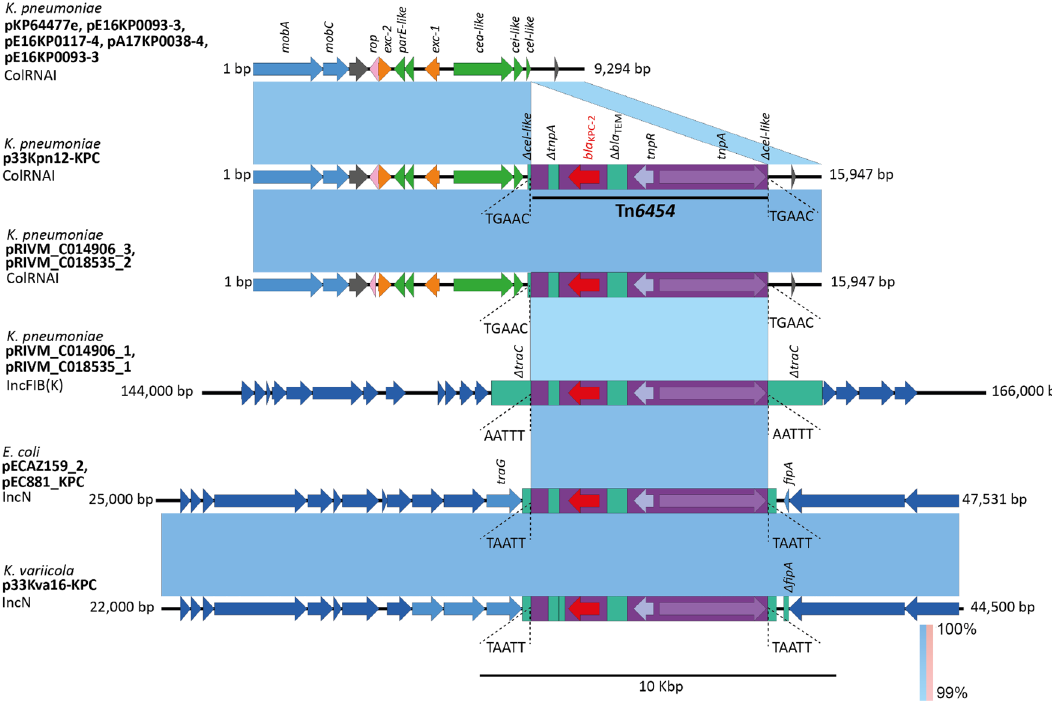
Figure 6. Comparative genomics of the plasmid p33Kpn12-KPC (CP062794) (ColRNAI) and p33Kva16-KPC (JAGTWT010000009) (IncN) harboring the new transposon Tn 6454 , a genetic element previously found in K. pneumoniae ColRNAI and IncFIB plasmids, and E. coli IncN plasmids. The shaded area between the sequences delimits the alignment regions with a percentage identity ≥ 99%. The blue arrows indicate the open reading frames and adjacent to the gene of interest, the coding regions for transposases (purple), resolvases (lilac), resistance genes (red) are highlighted, the transposons are delimited in a purple rectangle. The duplication sites (TSDs) generated by the transposition were illustrated and delimited in dotted lines for each mobile genetic element. The graph has a scale line of 10,000